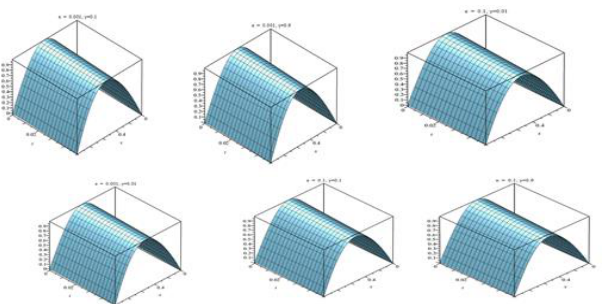
Fig. 5. Effect of Reaction 𝛾 on the solution 𝑢(𝑥, 𝑡)